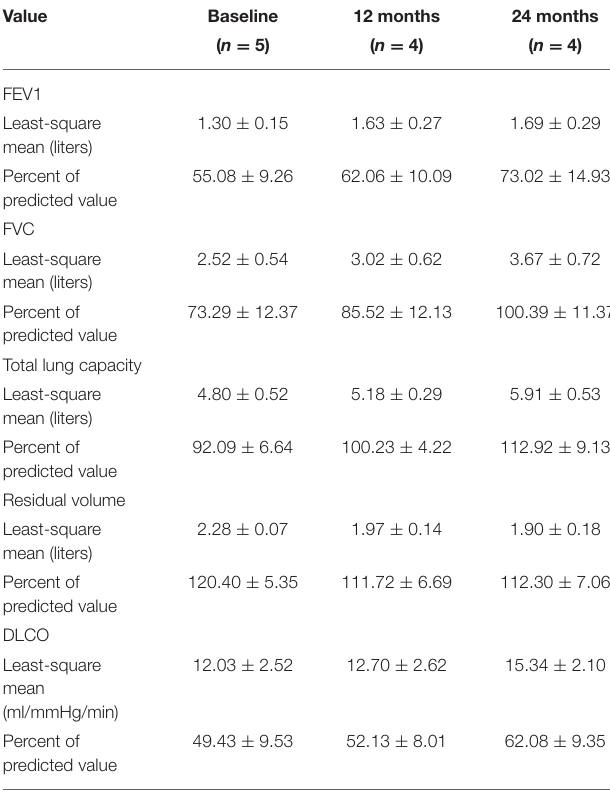
TABLE 4 | Pulmonary functional characteristics of patients with